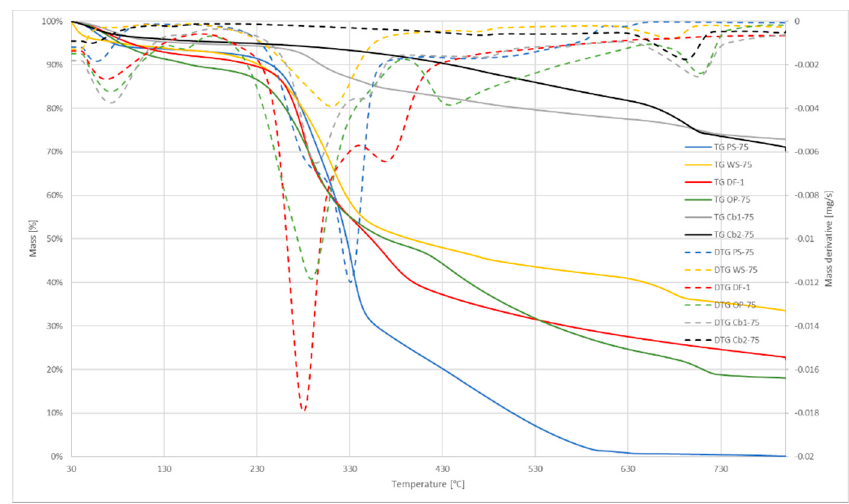
Figure 2. Air atmosphere TG and DTG curves.